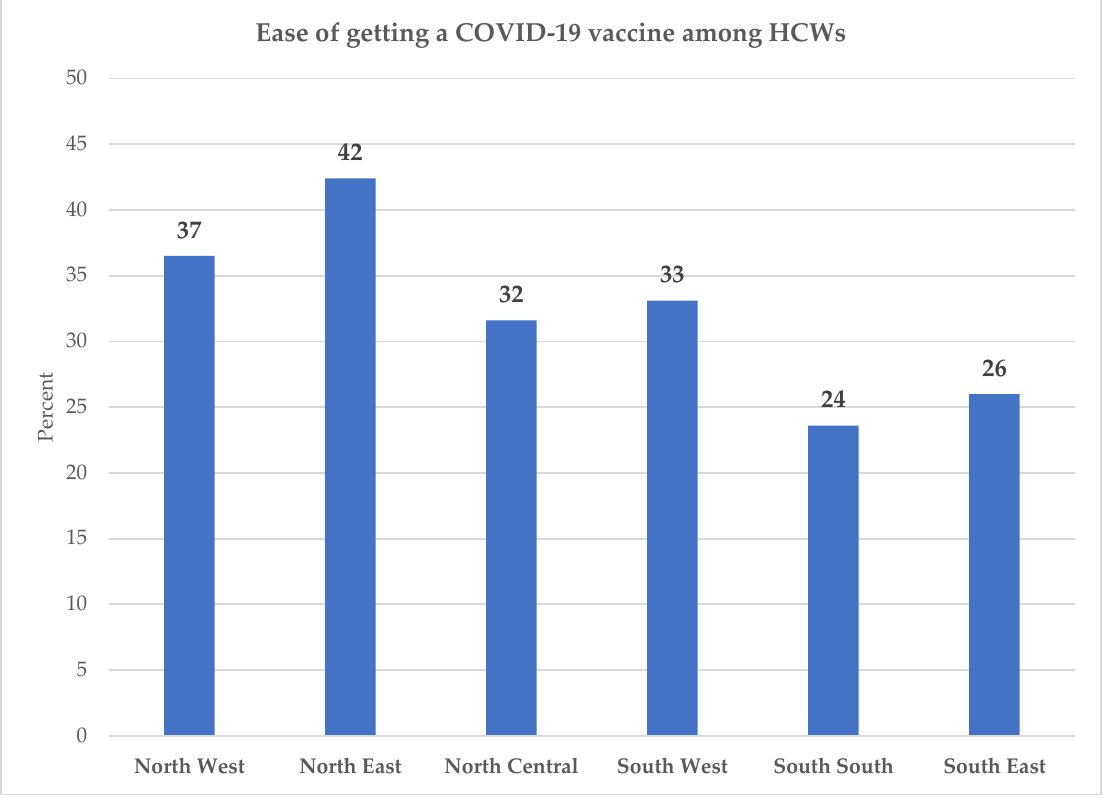
Figure 4. Percent of HCWs who find it very easy to get a COVID-19 vaccine by region.